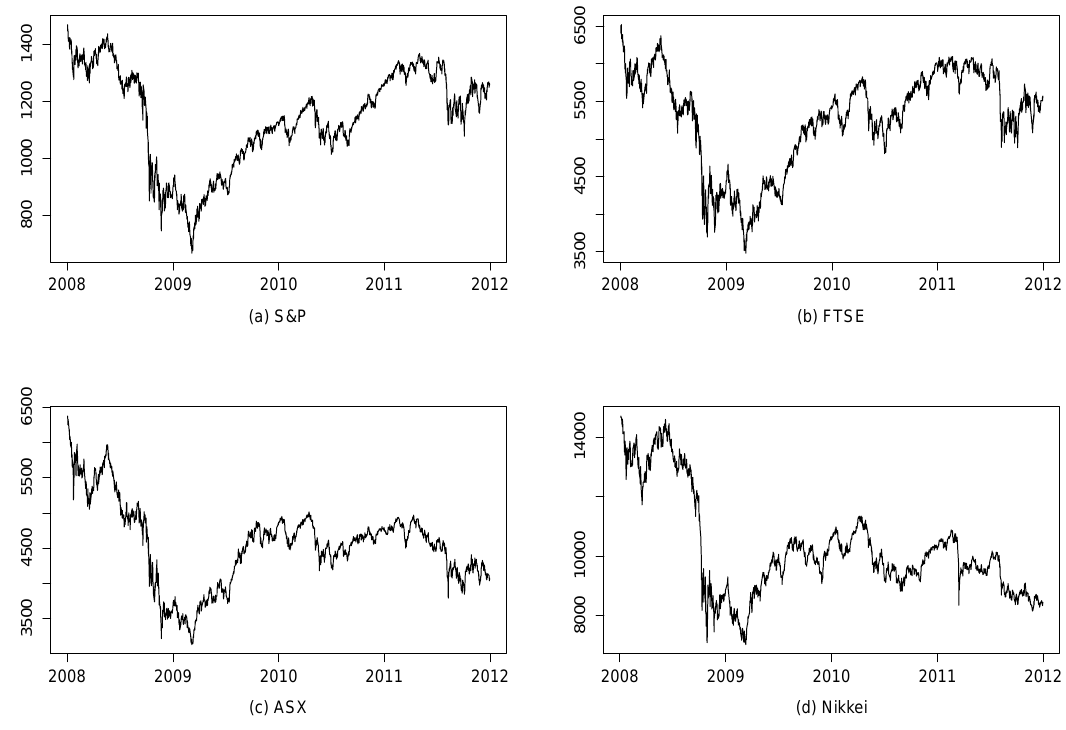
Figure 2. Hourly closing prices for the selected indexes over the period 1 January 2008 to 31 December